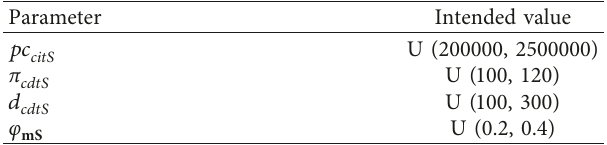
Table 11: Total probabilities of possible scenarios. Table 12: Different parameters under possible scenarios.